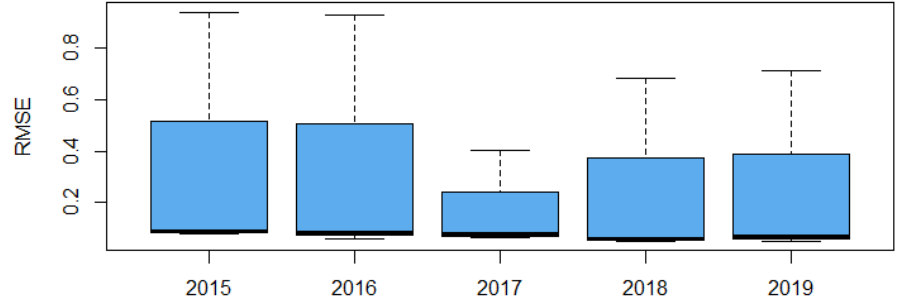
Figure A4. Prediction root mean square errors (RMSE) for different years in the test dataset.